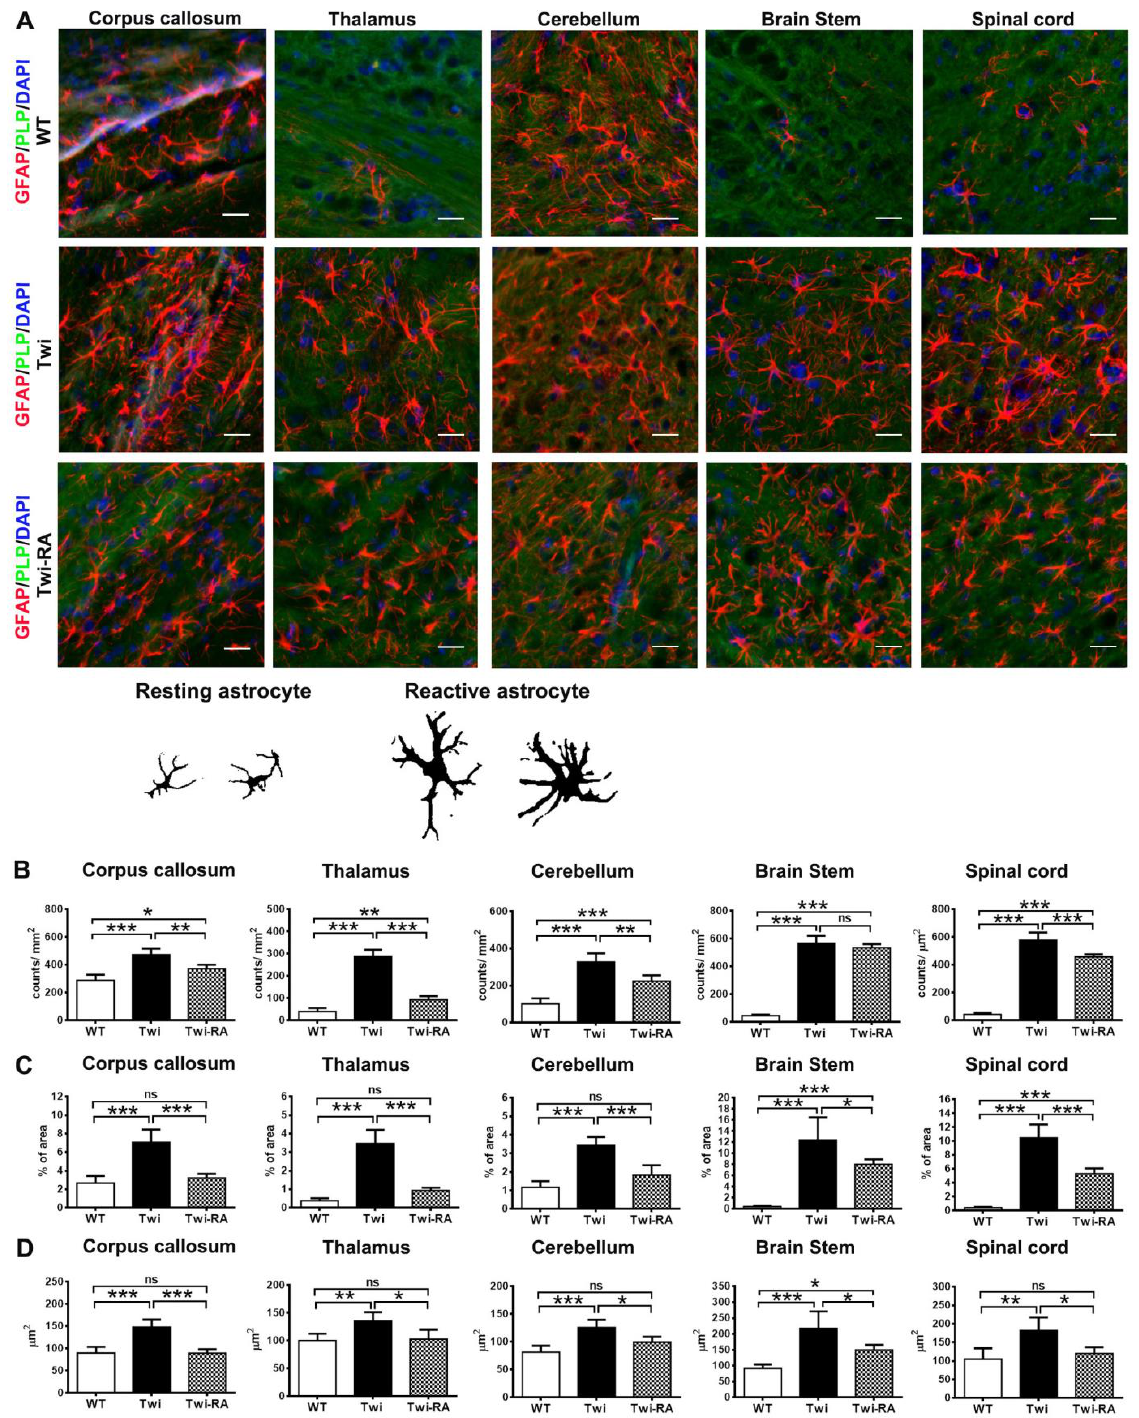
Figure 5. Rapamycin alleviates activation of astrocytes. ( A ) Representative images of GFAP (red), PLP (green), and nuclei (DAPI) immunostaining in different regions of the brain of wild-type (WT), untreated twitcher (Twi), and rapamycin-treated twitcher (Twi-RA) mice at 35 days of age. Scale bars: 25 μm. ( B ) Representative images of resting and reactive astrocytes. Total amounts of astrocytes per square millimeters ( B ), the percentage of area occupied by astrocytes ( C ), and the average size of astrocytes ( D ) were quantitatively analyzed with ImageJ. Values are expressed as mean ± SEM and compared using One way ANOVA (Tukey post hoc test) ( n = 5). Statistical significance, * p < 0.05, ** p < 0.01, *** p < 0.001, and ns (not